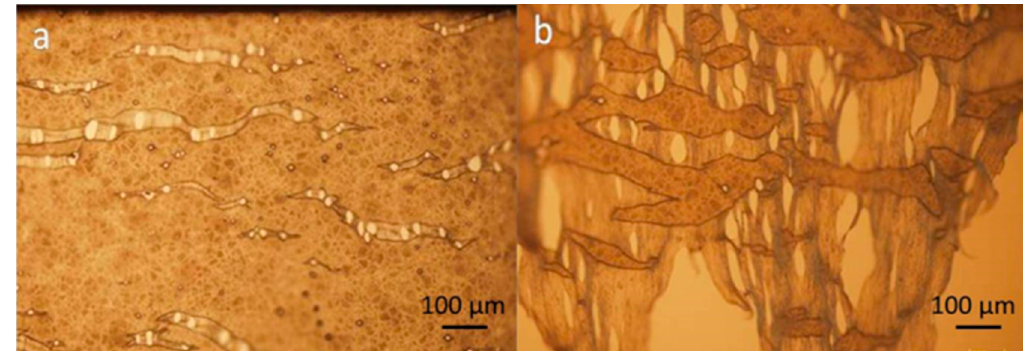
Figure 4. Failure mode ( a ) Near the sample holding grip ( b ) In the middle of a sample.